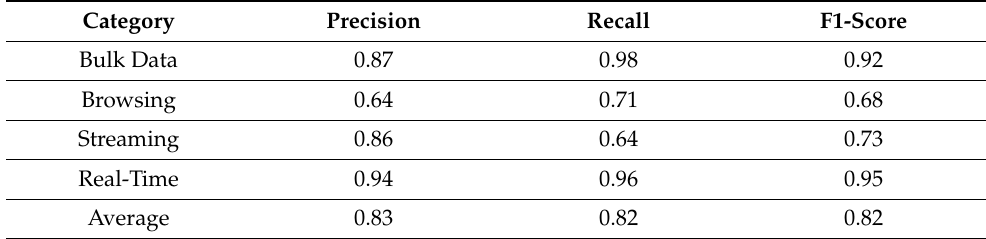
Table 9. P-MLP model test classification